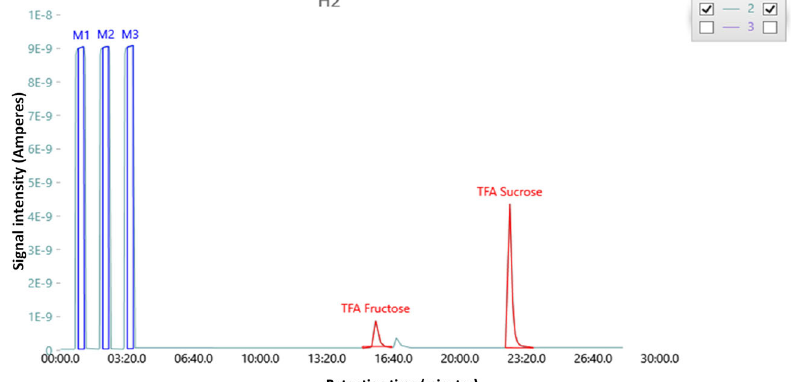
Fig. 1 Ion chromatogram of a sugar extract from authentic pineapple juice. The m/z 2 trace shows the sugars as their corresponding tri fl uoroacetate (TFA) derivatives, analysed by GC – CrAg/HTC –